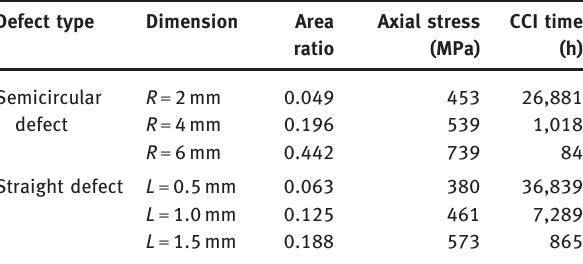
Table 3: The summary of simulated results for different defects. Defect type